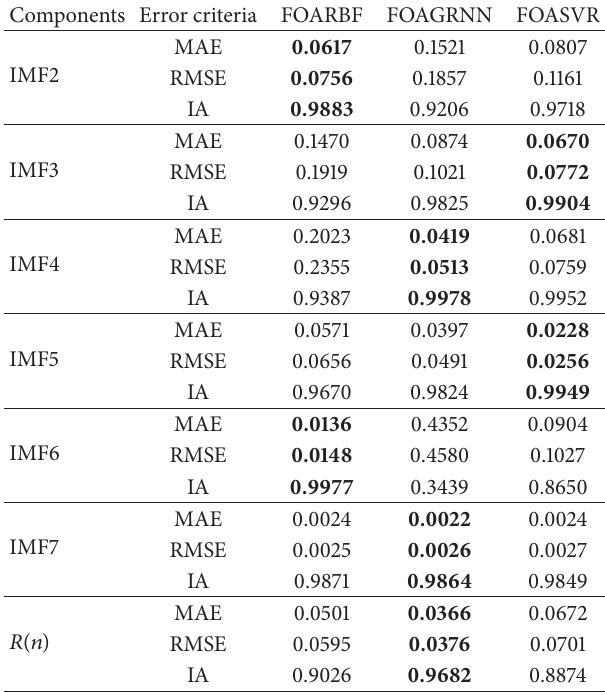
Table 5: The forecasting results of model selection among the FOARBF, FOAGRNN, and FOASVR in summer.